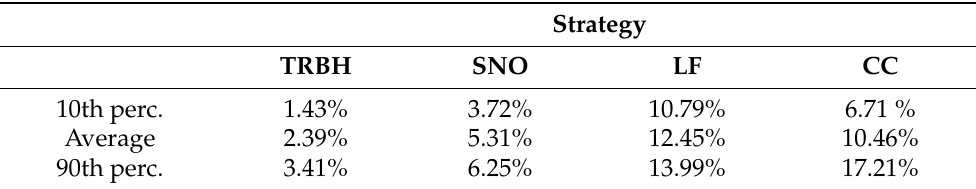
Table 1. Average gap attained by each method over all simulated days of operation. The 10th and 90th percentiles are also shown, to give an idea of the reliability of the scheduling approach in operating days with different characteristics.